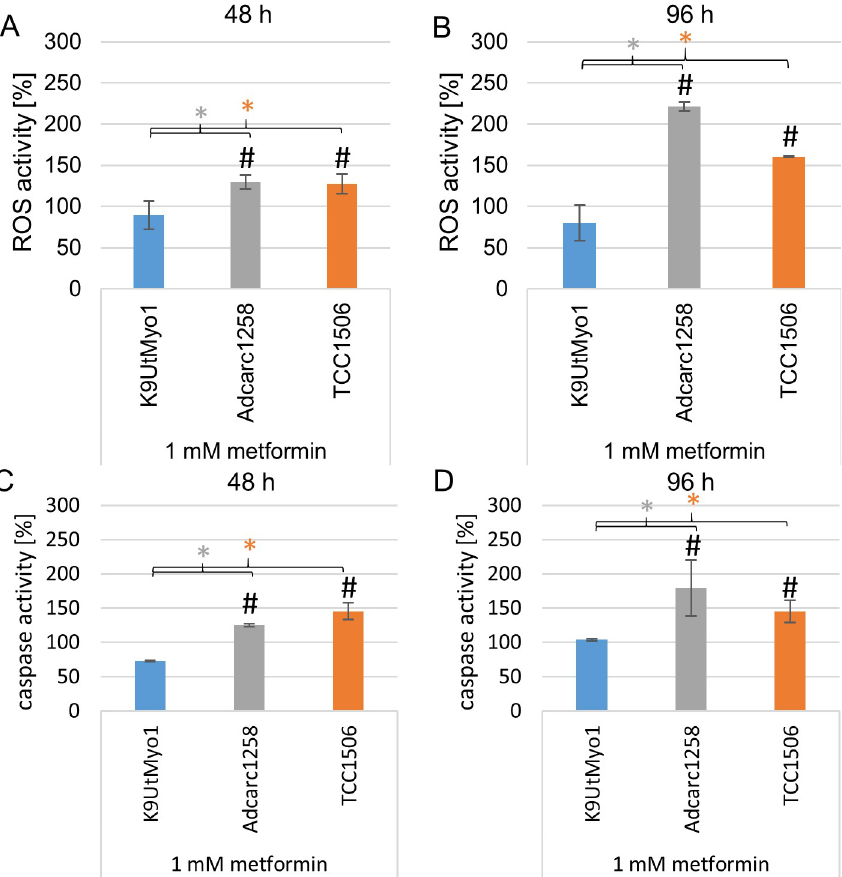
Fig 5. Mitochondrial ROS production (A and B) and caspase-3/7 activity (C and D) of K9UtMyo1, Adcarc1258, and TCC1506 after single 1 mM metformin application over 48 h (A, C) and 96 h (B, D). An untreated control of the respective cell line served as a 100% reference. Means and standard deviation are displayed, n = 3. Gray asterisk: significant difference between K9UtMyo1 and Adcarc1258. Orange asterisk: significant difference between K9UtMyo1 and TCC1506. Black number signs: significant difference in comparison to the control. Significance is set at p < 0.05.